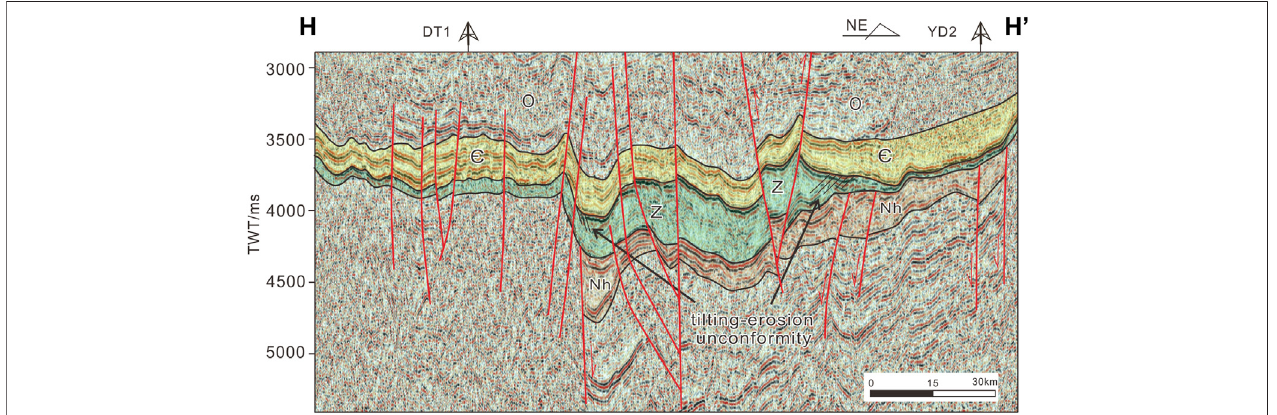
FIGURE 7 | Interpreted seismic pro fi le of the angular unconformity (see Figure 3 for locations).